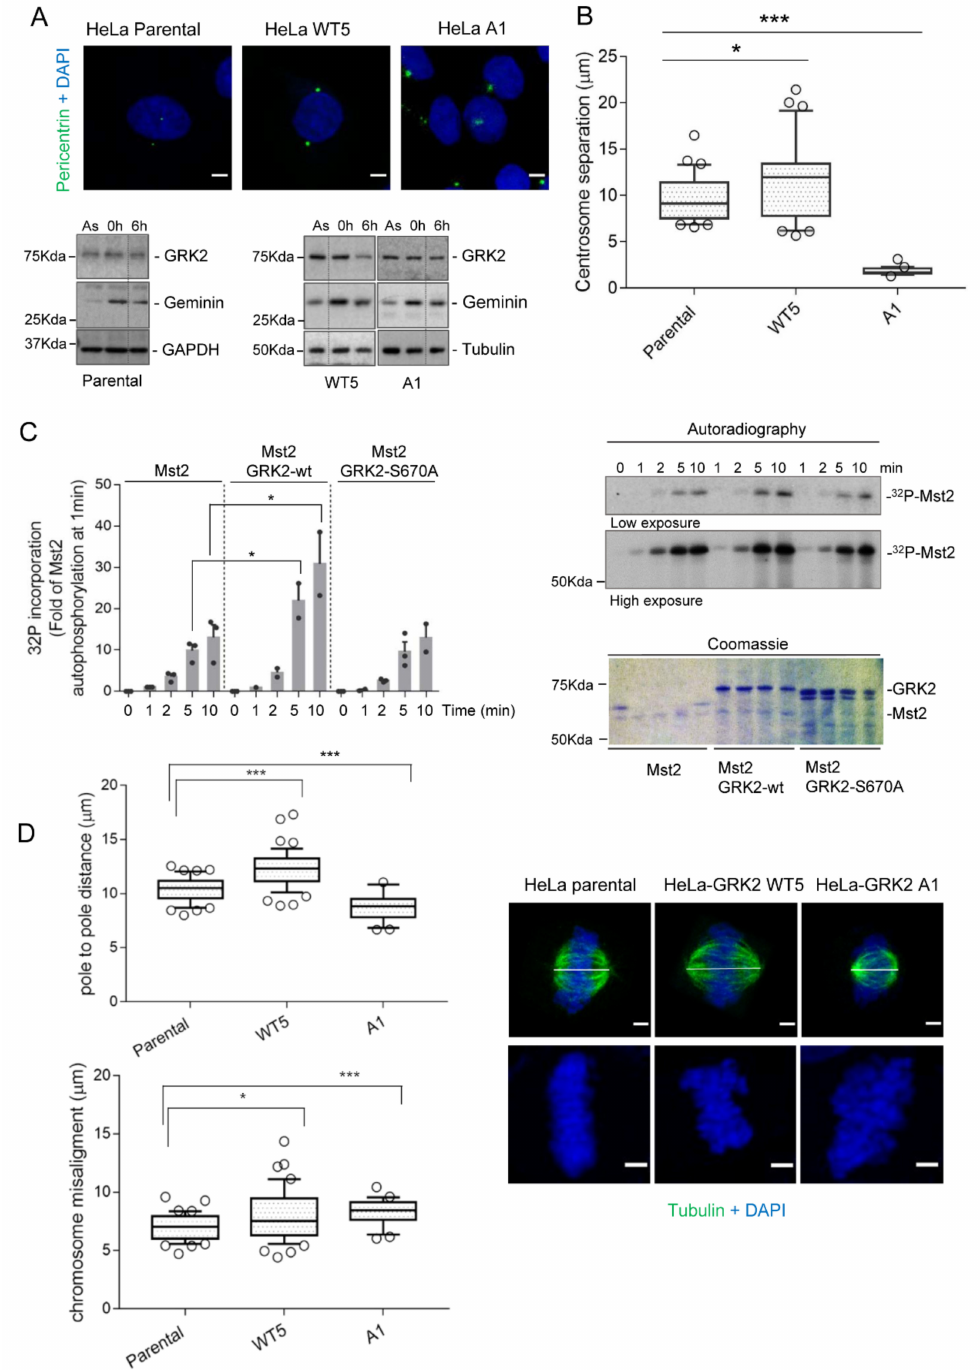
Figure 5. Proper centrosome separation in the G2 and chromosome alignment depends on Ser670 phosphorylation levels balancing Mdm2-mediated decay of protein levels and kinase activity of GRK2 towards MST2. ( A , B ) Centrosome separation in the G2 directly correlates with protein levels of catalytically active and Ser670 phosphorylation-enabled GRK2. HeLa cells stable overexpressing wild-type (HeLa WT5) or mutant GRK2-S670A (HeLa A1) and parental cells were synchronized at G1/S transition and released into the cell cycle. After 6 h of progression, cells in late G2 were stained for pericentrin (green) as centrosome marker and DNA (DAPI, blue) ( A ). Representative confocal images are shown. Scale bar, 5 µ m. Protein levels of GRK2 and geminin as a marker of similar cell cycle progression from S to the G2 phase were analyzed by Western blot in cells growing asynchronously, arrested at G1/S transition (0 h) or progressing 6 h after release from G1/S arrest. Tubulin and GAPDH levels were used as loading controls. Dotted lines indicate cropped lanes from the same blot. ( B )